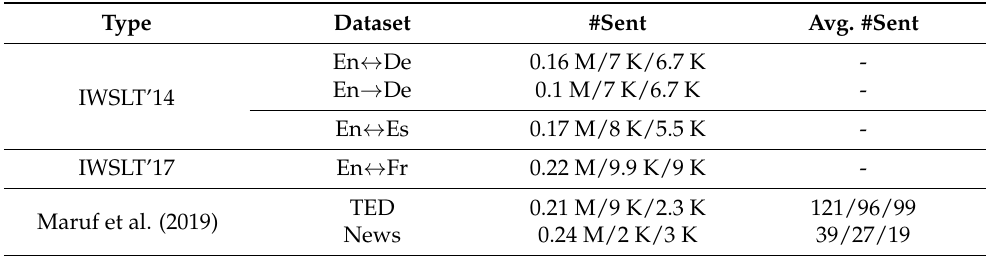
Table 1. Statistics of document-level machine translation